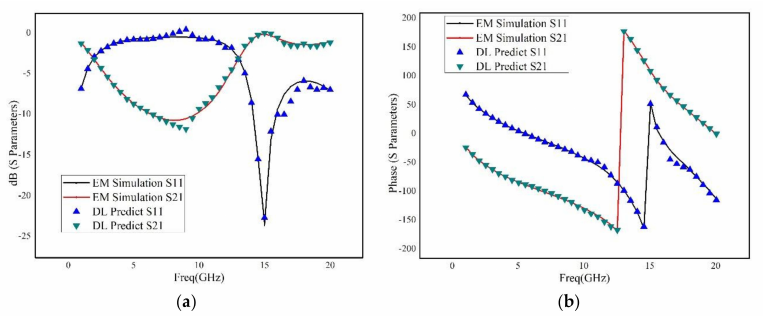
Figure 6. Results of the deep learning versus the EM simulation for non-uniformly sampling when a 2-hidden-layer neural network with 20 neurons on each layer is used. ( a ) dB of S Parameters. ( b ) Phase of S Parameters.